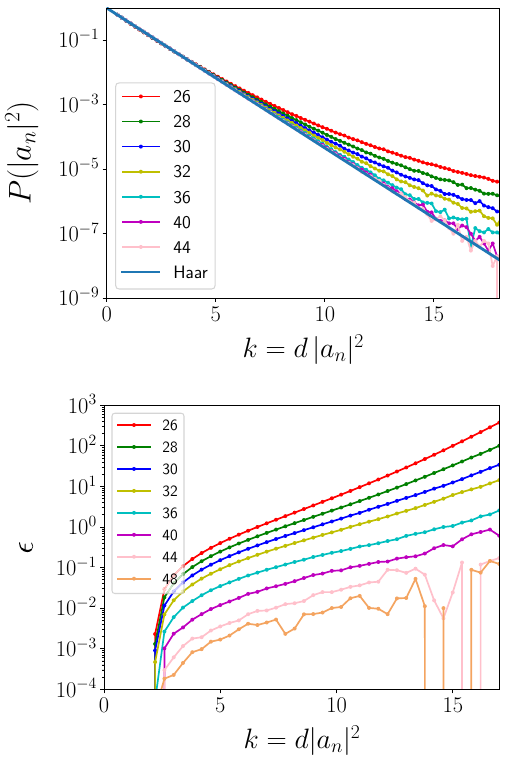
FIG. 9. Top: the probability distribution of bit strings in the x basis in automaton circuits at different depths. Lower depth cir- cuits have large fluctuations above the Porter-Thomas bound at high k . Bottom: we quantify the cumulative error given by Eq. (A3). At fixed k , the error decreases exponentially with circuit depth. At fixed circuit depth, the error increases exponentially with fluctuation size k = d | a n | 2 .